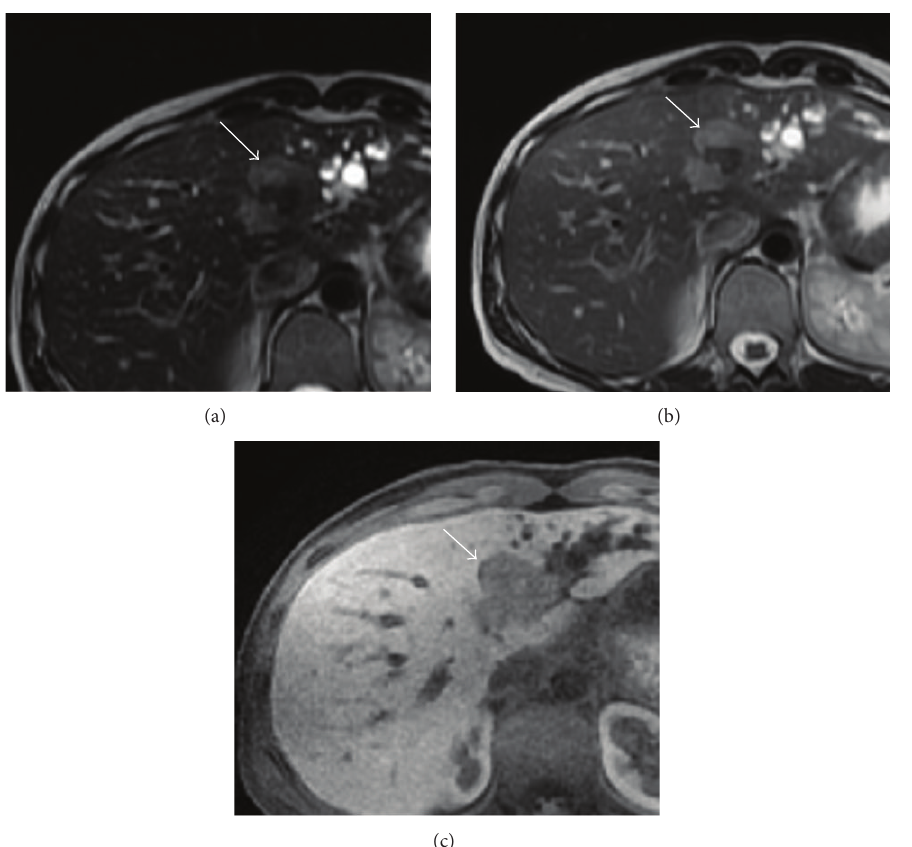
Figure 1: MRI of a lobulated lesion in segments 2 and 4 (white arrow). (a) T2 weighted first echo. (b) T2 weighted second echo. (c) Delayed liver acquisition with volume acquisition (LAVA).